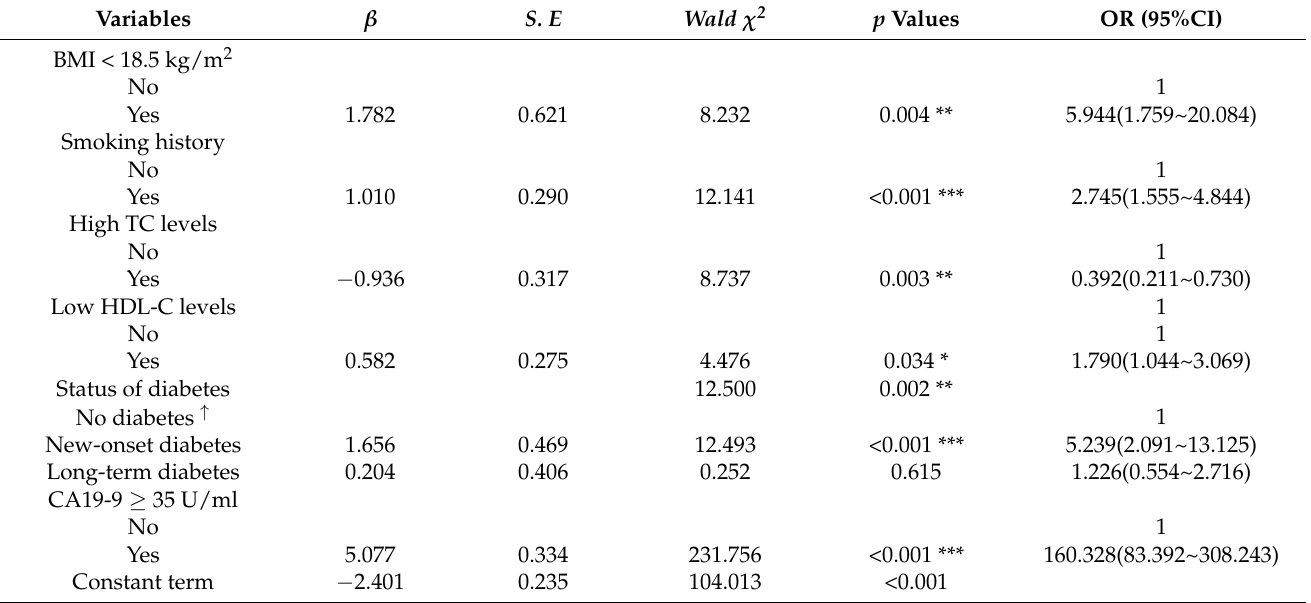
Table 3. Logistic regression analysis of risk factors for